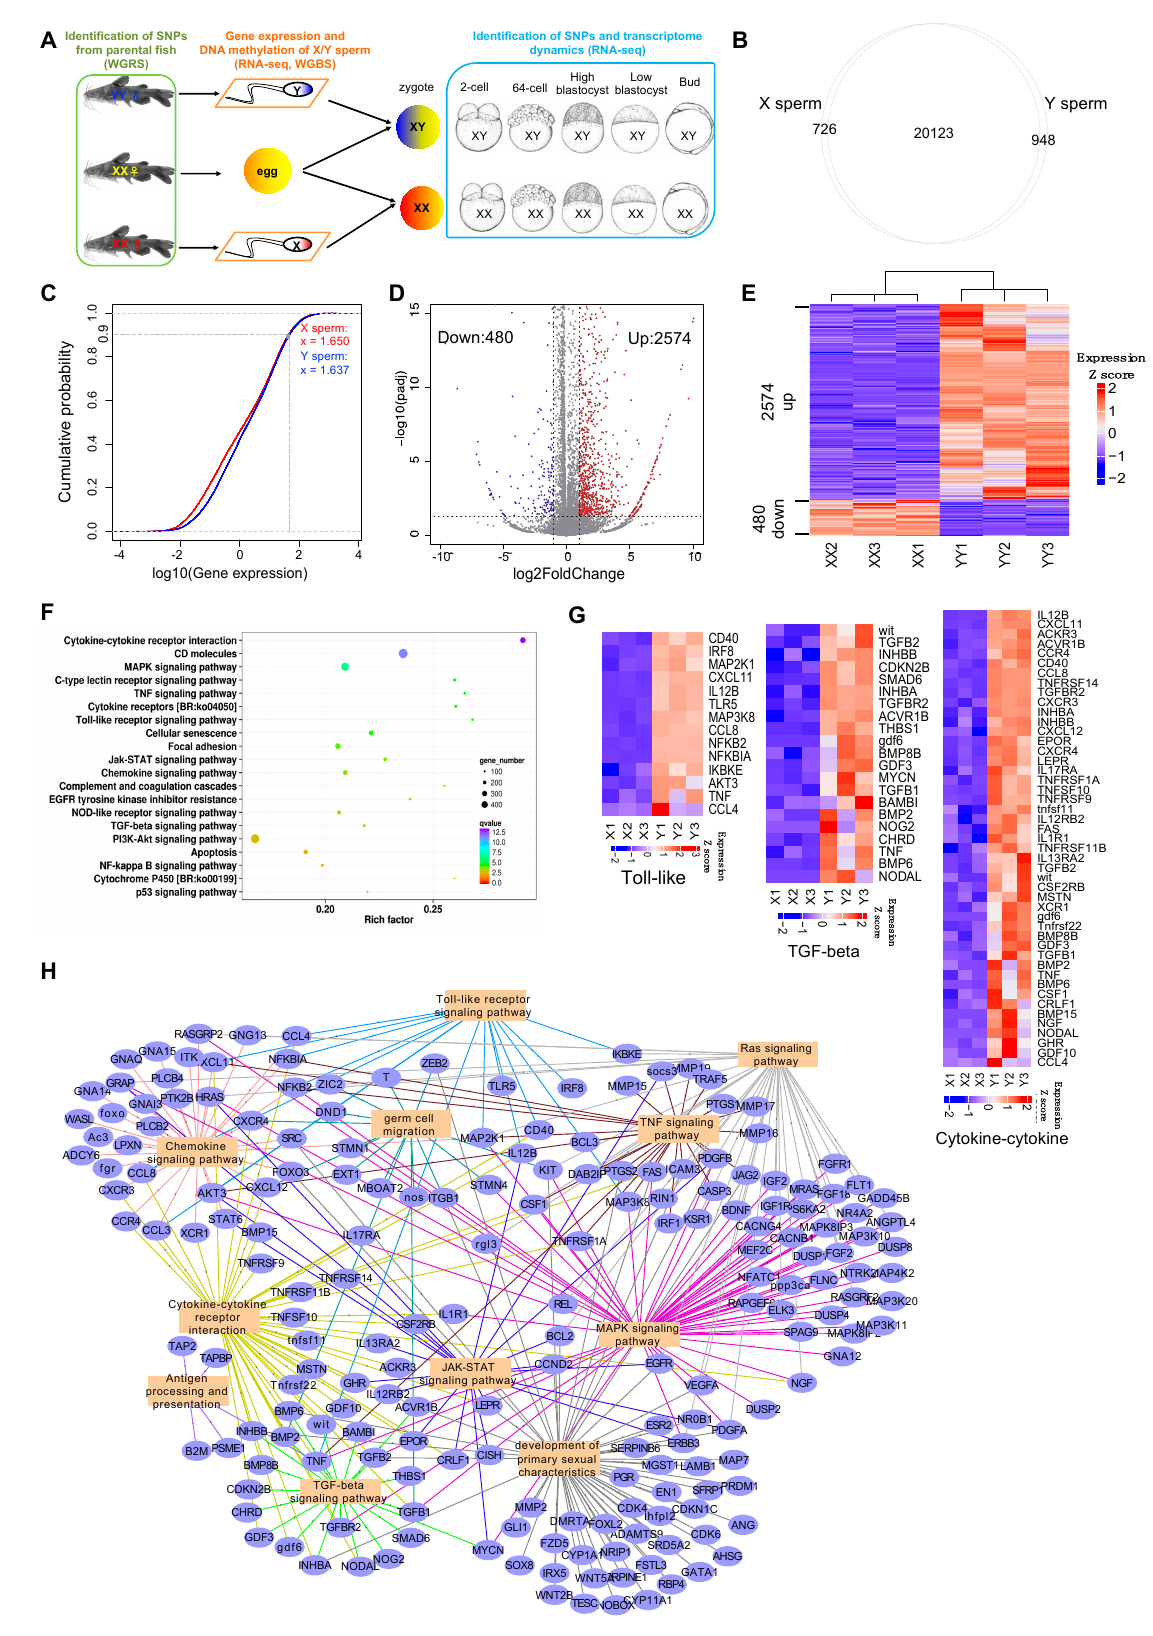
Figure 1. Overall design and gene expression summary of X sperm and Y sperm experiment. ( A ) Parental fish, generation of gametes and zygote, and sequencing strategies for fish, gametes,